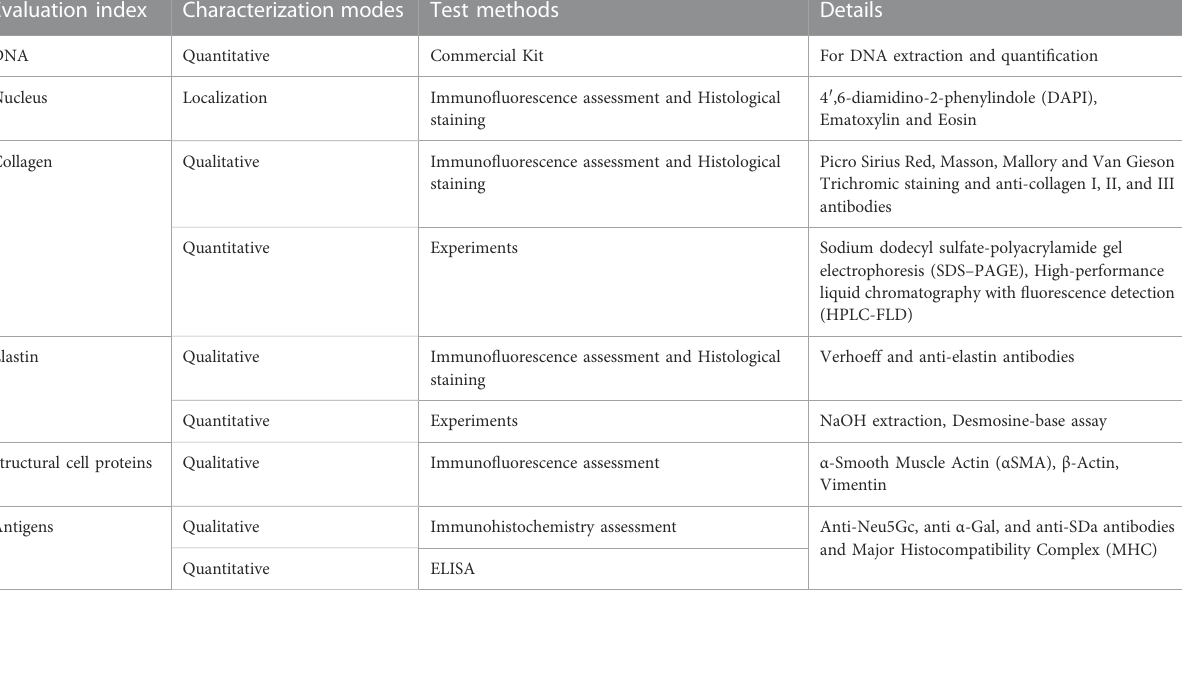
TABLE 3 Physical treatments used for